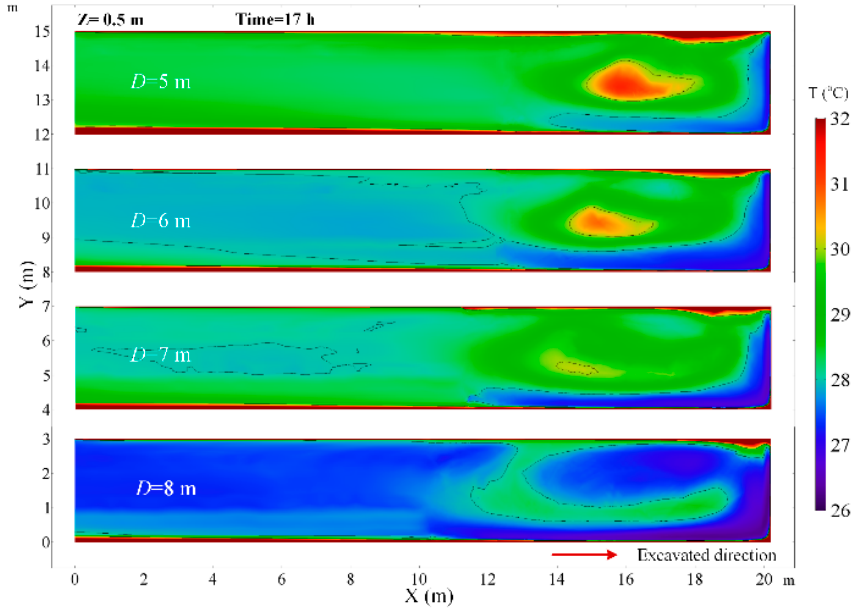
Figure 12. Air temperature distribution in Z = 0.5 m plane under different distance between duct outlet and working face.